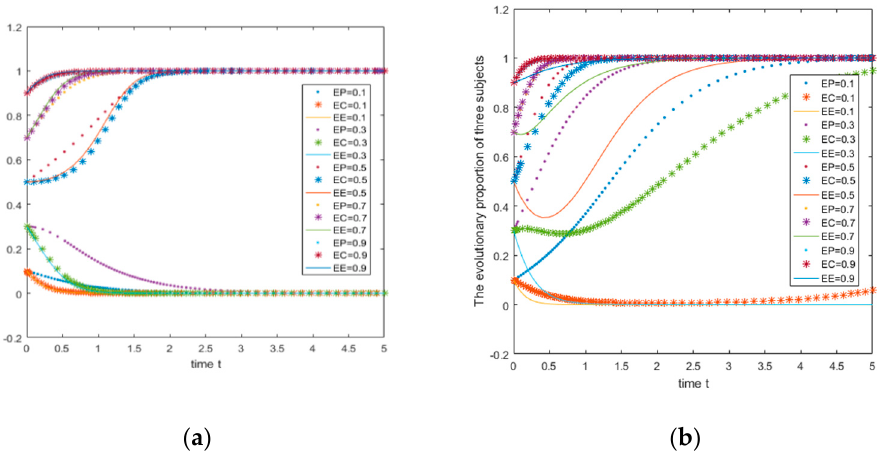
Figure 6. Different strategies correspond to the evolution graph under different basic income sce ‐ narios (the benefit of consistent action is the same).